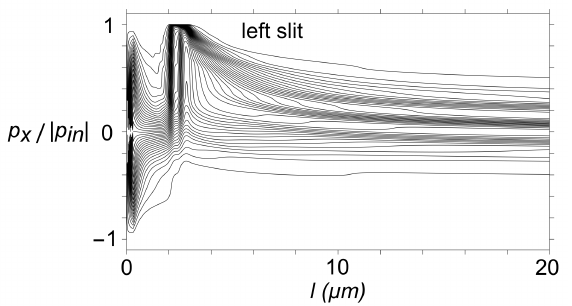
Figure 7. The momentum p x in the x direction, normalized to the incident momentum, is shown as a function of the distance l traveled behind the double slit (which increases proportionally with τ ), for different photon worldlines. As l increases, the photon worldline readjusts such that also the momentum changes. To ensure local momentum conservation at the double-slit interaction event, the momentum recoil of the double slit is the opposite of the photon momentum change. It should be stressed that this momentum is associated with the complete worldline after the double slit as a function of τ , which differs from how ordinary momentum changes as a function of time for a standard particle